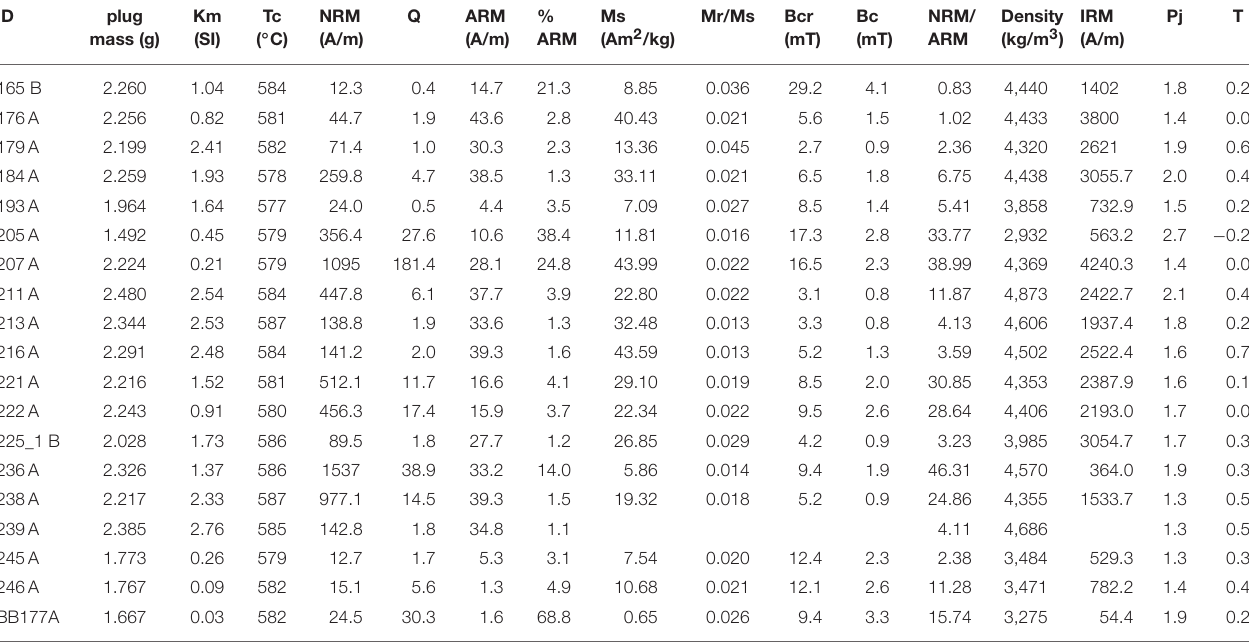
TABLE 1 | Table summarizing the key values measured on the 19 samples selected for magnetic mineralogy measurements. ID plug mass (g)